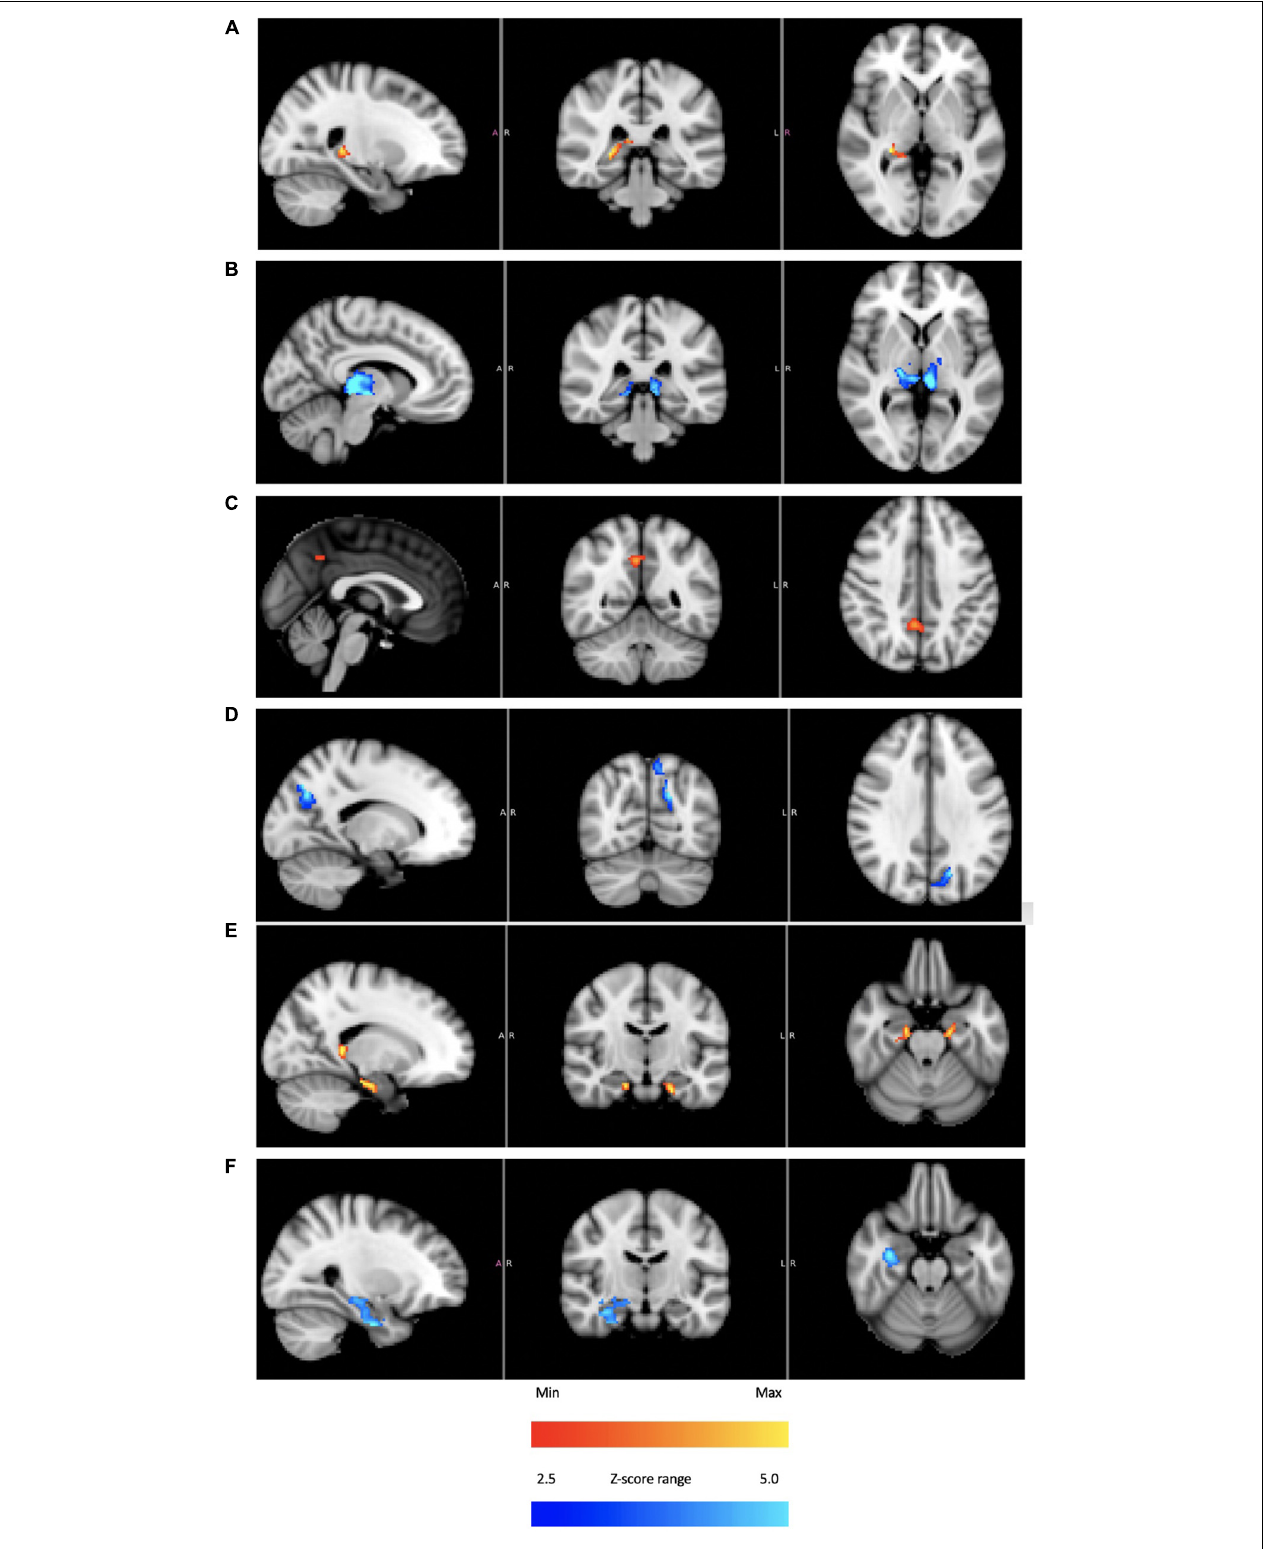
FIGURE 8 | For subject 4: thalamus [ (A) plateaus dominant, (B) troughs dominant]; precuneus [ (C) plateaus dominant, (D) troughs dominant]; hippocampus [ (E) plateaus dominant, (F) troughs dominant]. The color bars show relative z-score values. The orange/red and blue/aqua color bars are not related to each other.